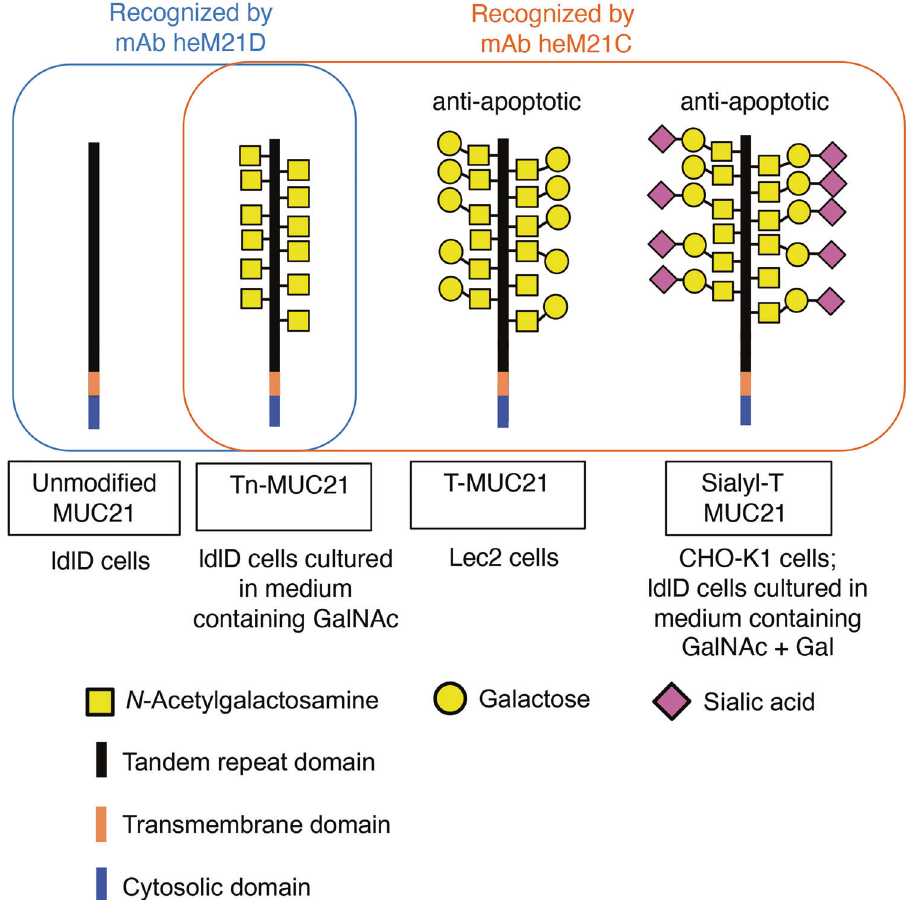
Fig. 8 Summary of the fi ndings of the current study. The MUC21 glycoforms expressed by the cell types and under the medium supplementation conditions used in the current study are shown together with the antiapoptotic properties of these MUC21 glycoforms. The binding speci fi cities of monoclonal antibodies (mAb) heM21D and heM21C are indicated with a blue and a red box,